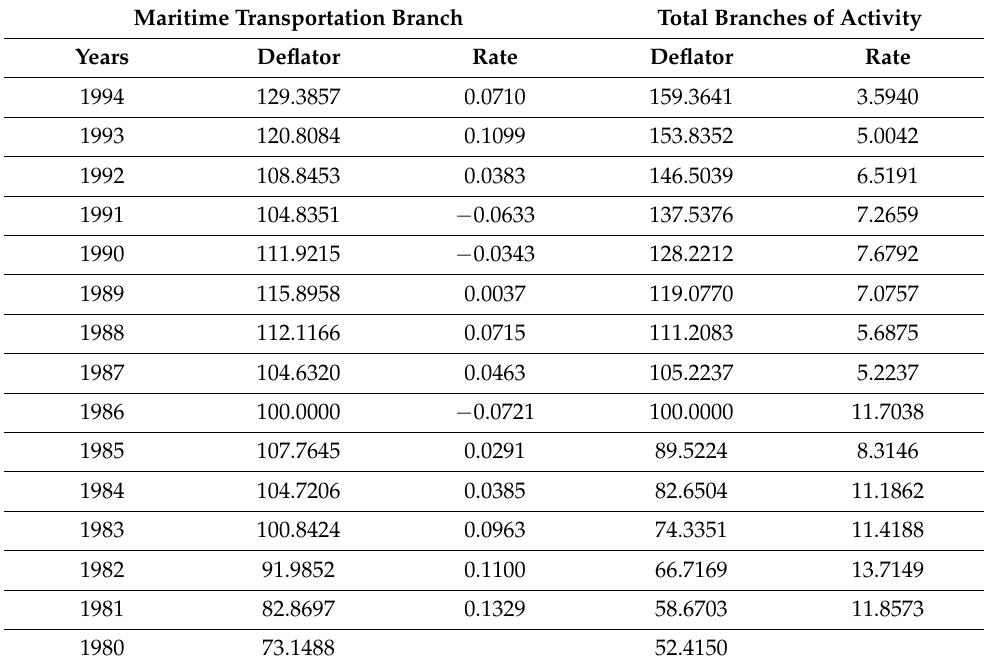
Table 6. Deflator and price variation rates for maritime transportation in state ports of